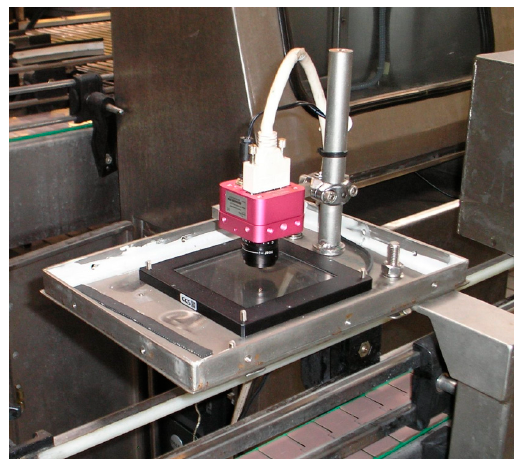
Figure 1. The plant system, which consists of a camera, illumination system, and support. The computer is in the background, and the conveyor belt system is underneath. The system is protected by a metal box not shown in this image that serves as a dark chamber.